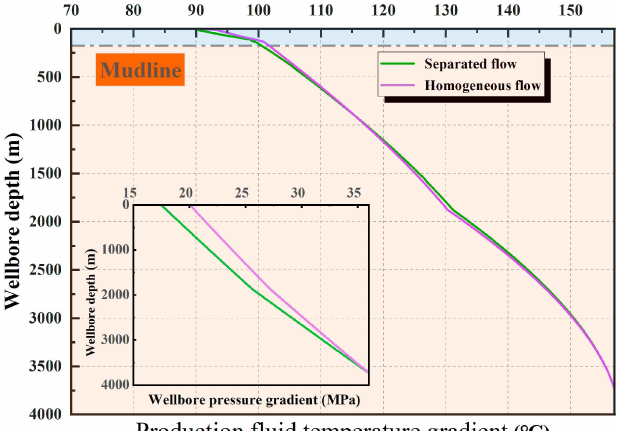
Figure 5. Wellbore temperature pressure